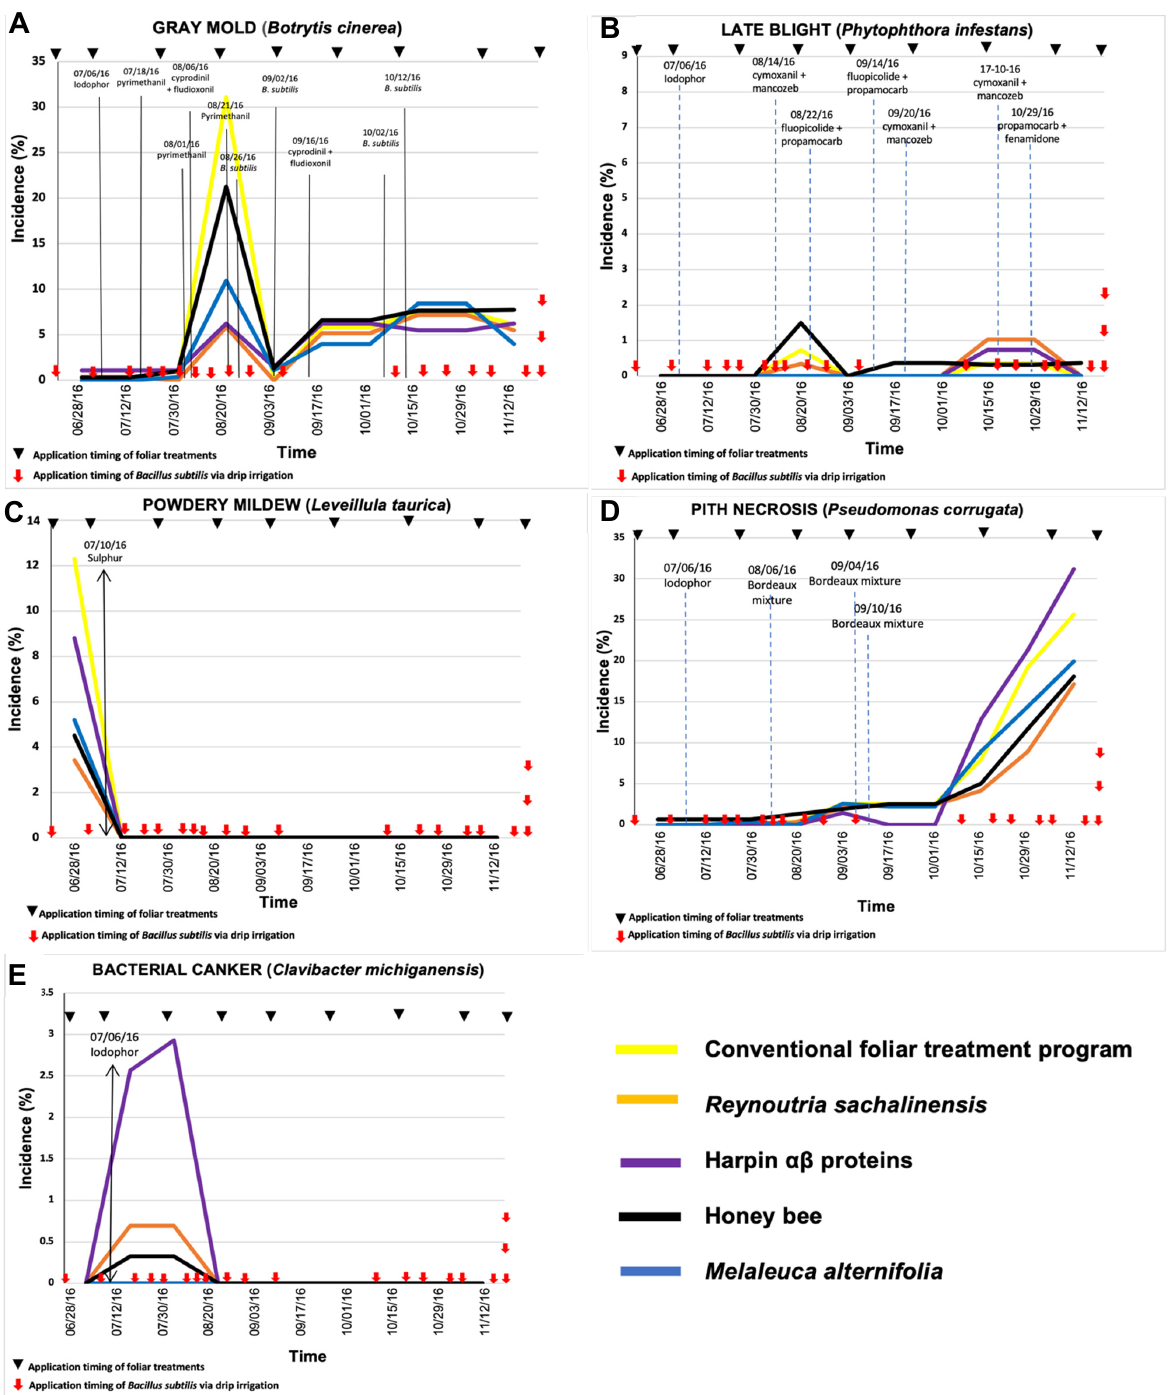
Figure 2. Temporal progress of major tomato diseases—( A ) gray mold ( Botrytis cinerea ), ( B ) late blight ( Phytophthora infestans ), ( C ) powdery mildew ( Leveillula taurica ), ( D ) pith necrosis ( Pseudomonas corrugata ), and ( E ) bacterial canker ( Clavibacter michiganensis )—in five different treatment combinations consisting of soil application of Bacillus subtilis via drip irrigation and foliar application of biorational products in tomato greenhouse production in Experiment 2 in 2016. Dotted vertical lines in graphs indicate the approximate timing of application of fungicides in the conventional management program or in any other treatment due to low-intensity tolerance to disease. Incidence values are the average of three replications.